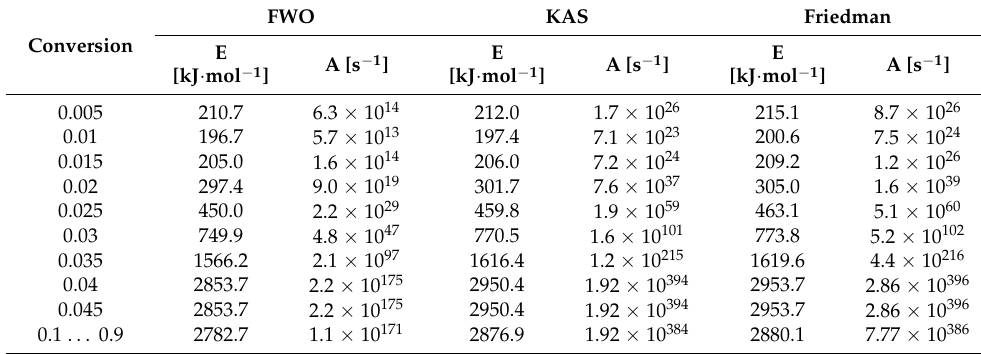
Table 14. Kinetic parameters of DNTT at heating rates of more than 3 min − 1 .